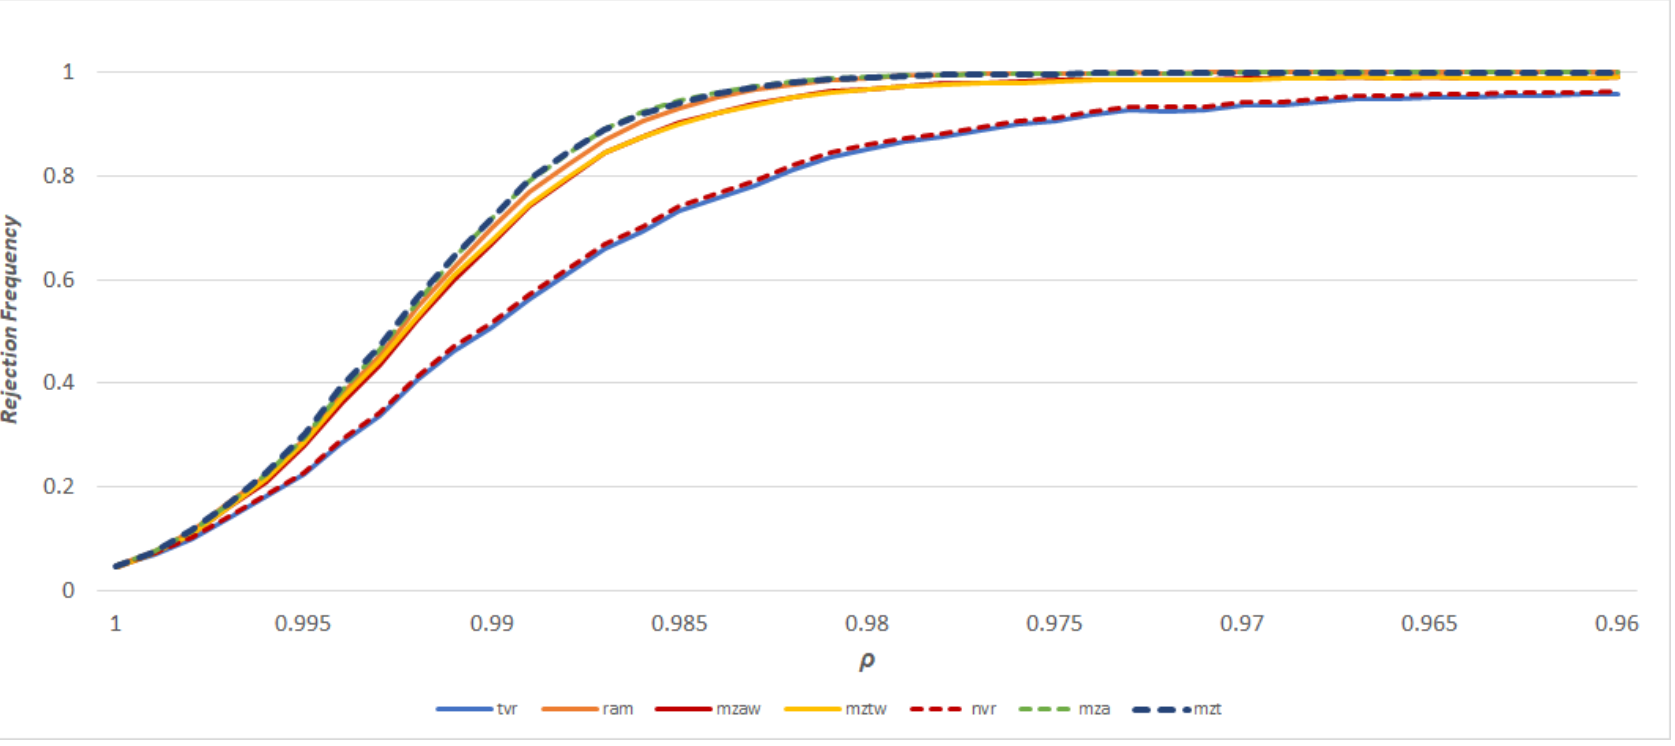
Figure 3. Asymptotic power curves of the wavelet based and standard unit root tests under GLS demeaning. Note: tvr , ram , mzaw and mztw correspond to τ ∗ , FG , MZ ∗ α and MZ ∗ nvr , mza and mzt correspond to τ , MZ α and MZ t which are standard unit root tests without the wavelet application, t , respectively.